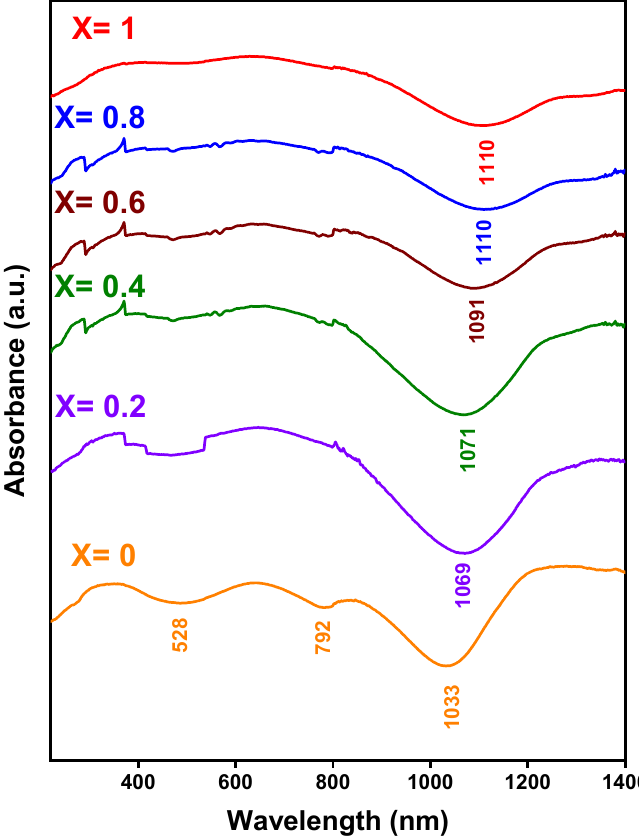
Figure 7. UV–Vis Absorbance spectra of Mn X Co 3-X O 4 (0 ≤ X ≤ 1) samples.